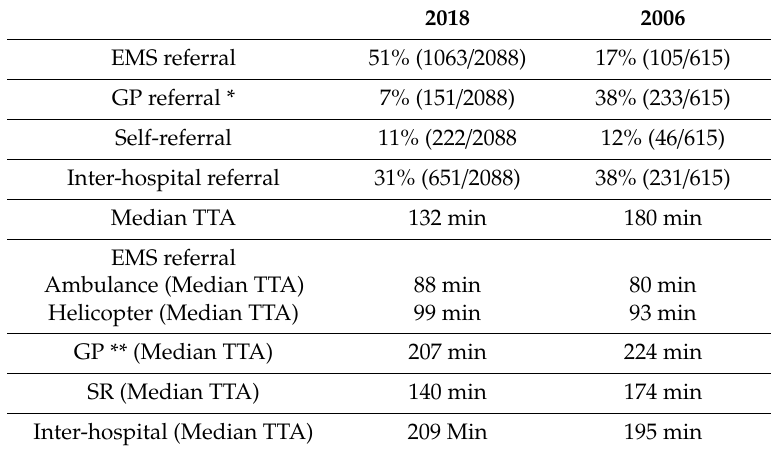
Table 1. Comparison of adj. TTA and adj. referral pathways in acute stroke 2018 with